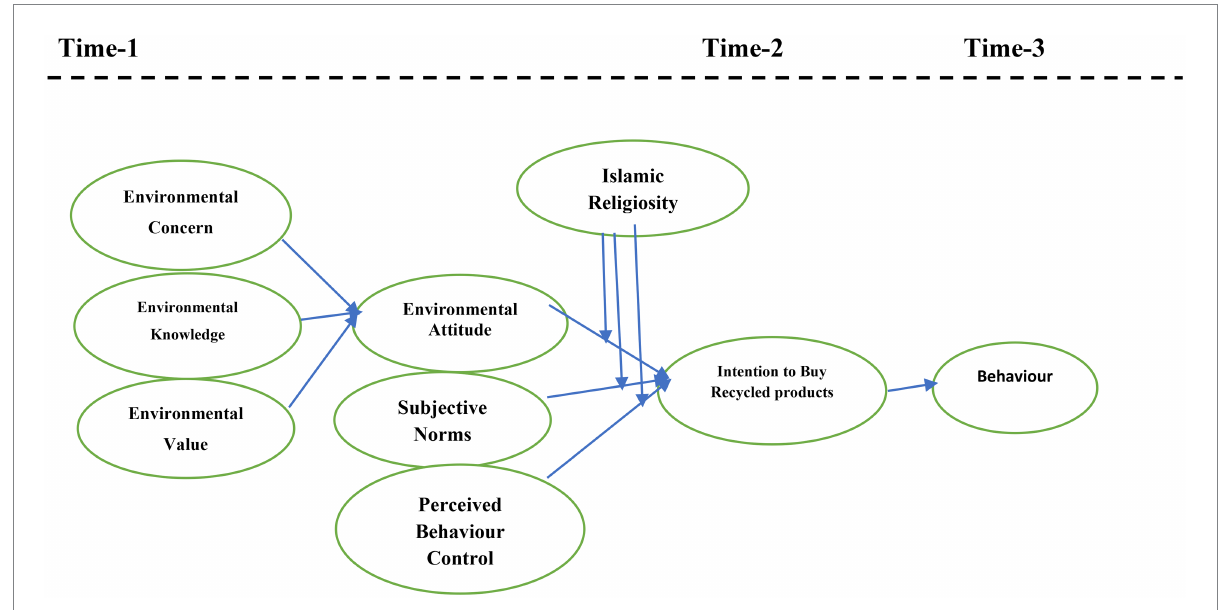
FIGURE 1 Theoretical framework of the